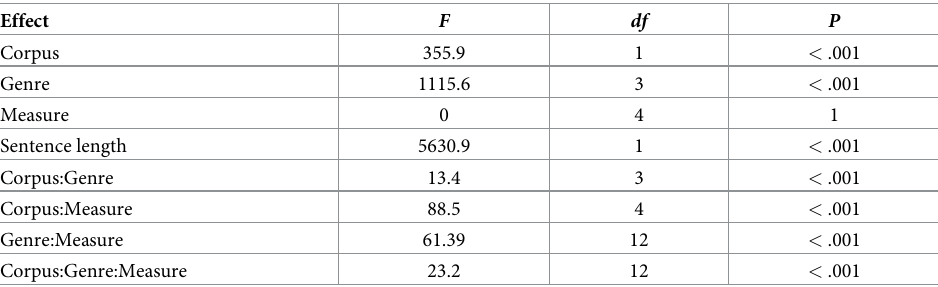
Table 3. ANOVA results in the main analysis.